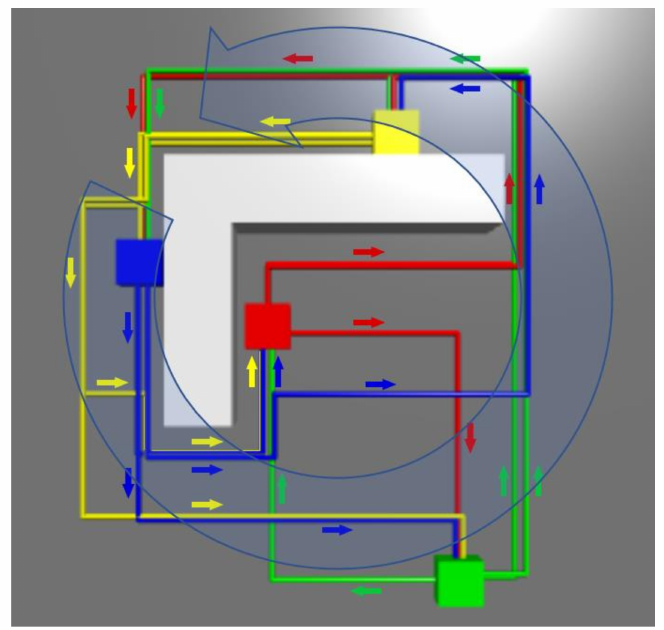
Figure 14. Circular traffic in a counter-clockwise direction around the